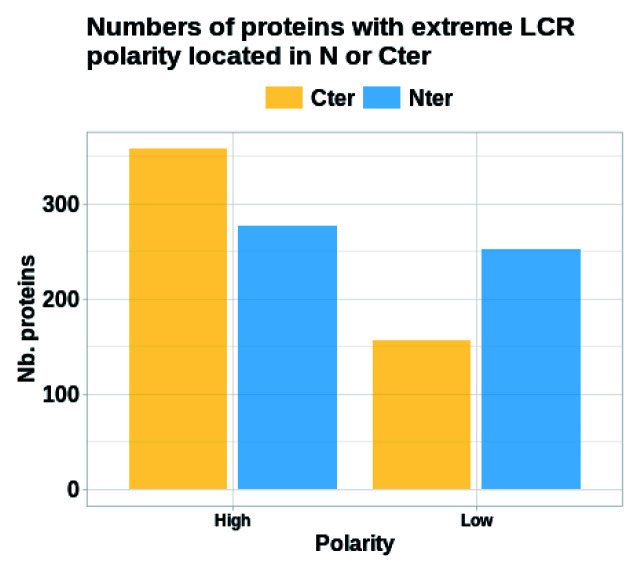
Numbers of proteins with High or Low polarity low-complexity regions (LCRs), located either in the N-terminal or C-terminal.